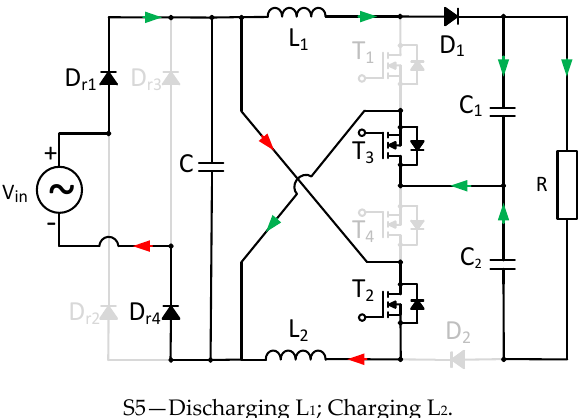
Figure 3. Switching stages for the proposed PFC converter.